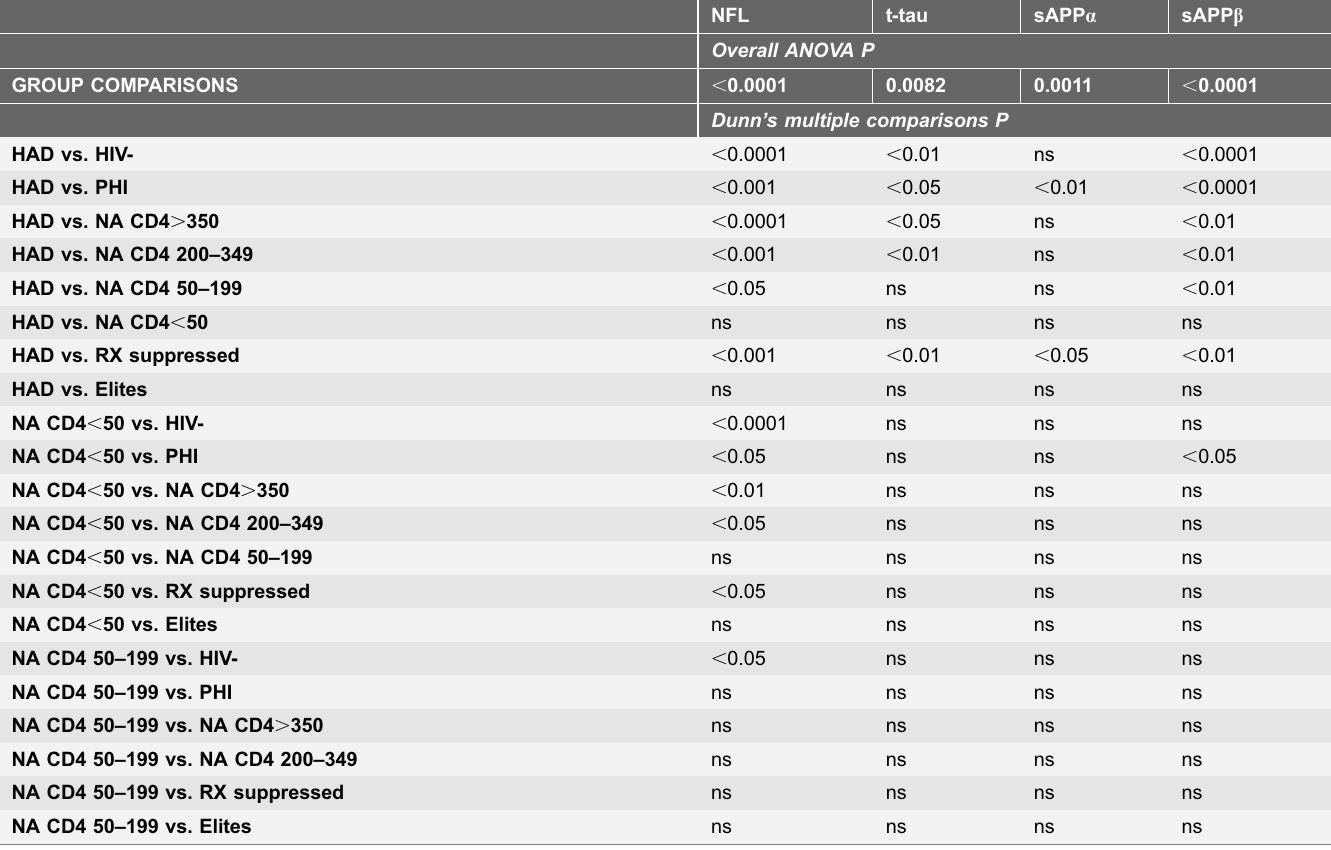
Table 3. Comparisons of CSF neuronal biomarker concentrations among subject